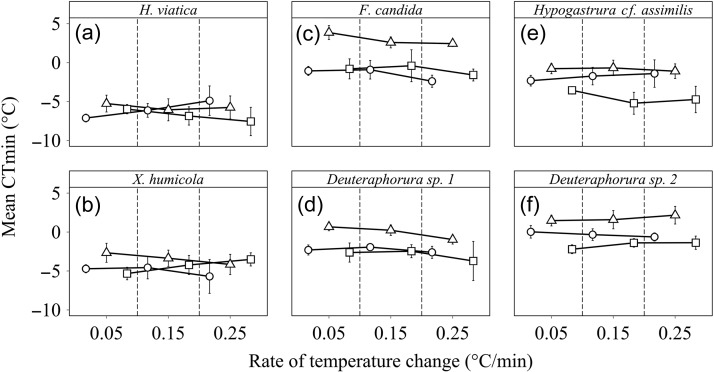
The effect of rate of temperature change and acclimation on the critical thermal
minimum (CTmin) of Hypogastrura viatica (polar; a),
Xenylla humicola (polar; b), Folsomia
candida (temperate; c), Deuteraphorura sp. 1
(temperate; d), Hypogastrura cf. assimilis
(sub-tropical; e) and Deuteraphorura sp. 2
(sub-tropical; f). Acclimation effects are: control (open circles, colony
temperature), high (open triangles,  colony temperature +10°C) and low (open squares,
 colony temperature −10°C). For each species, n = 26–31 at each rate
of temperature change for each acclimation treatment.